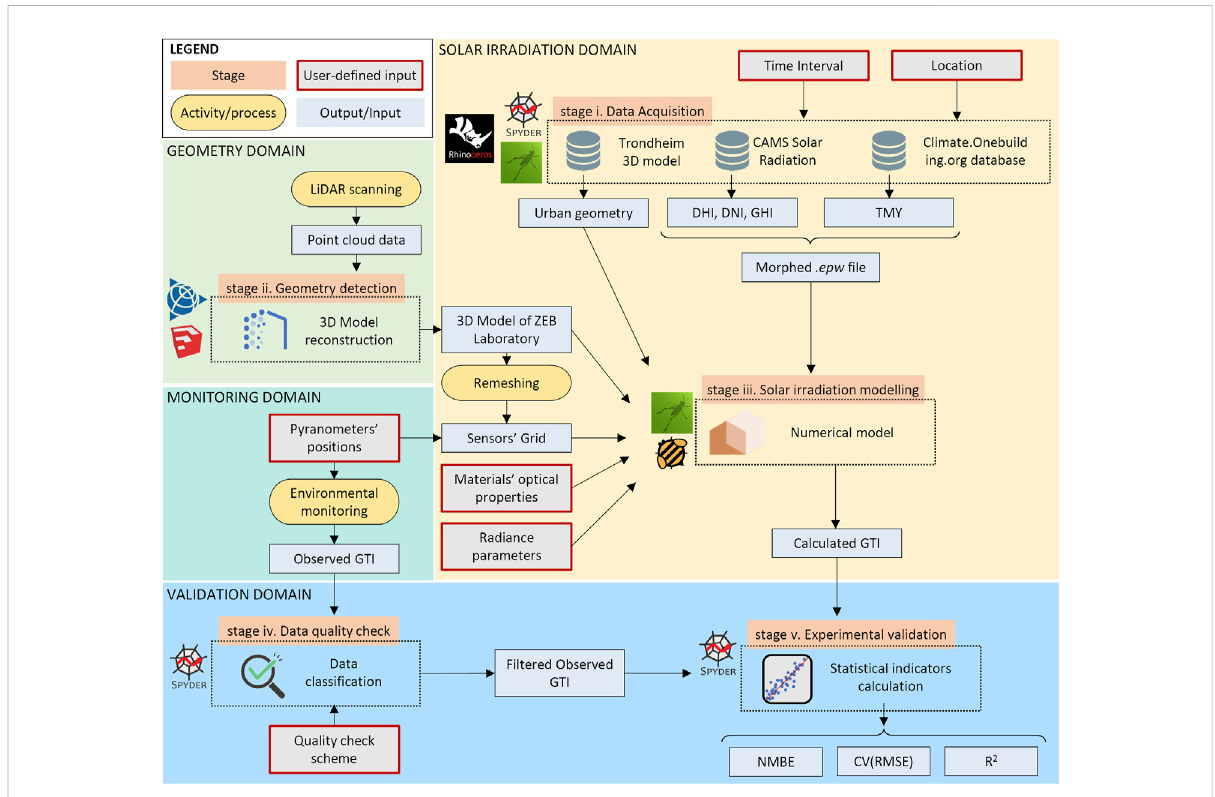
FIGURE 1 Overview of the work fl ow followed in this study. The main domains (e.g., solar irradiation domain, geometry domain, monitoring domain, and validation domain) are highlighted with different colors, while in the left corner, the four block typologies (e.g., stage, user-de fi ned input, activity/ process, and output/input) are